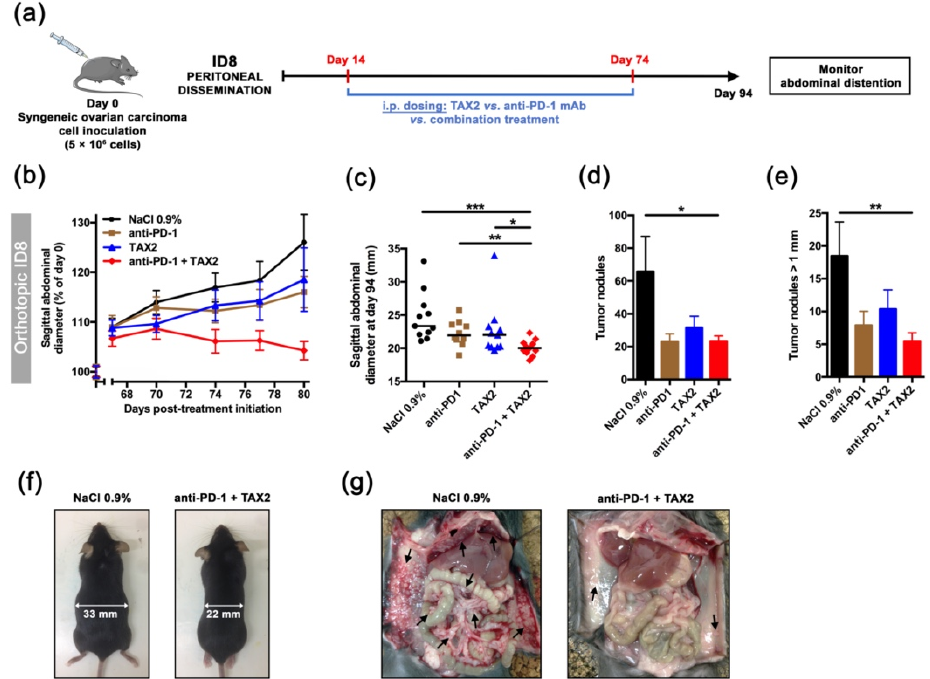
Figure 6. Validation in an orthotopic, syngeneic model of metastatic peritoneal carcinomatosis. ( a – g ) 5 × 10 6 ID8 cells were i.p. implanted in C57BL/6JRj mice in order to recapitulate peritoneal metastatic dissemination ( a ). On day 14, mice were randomized ( n = 11 per group) and then received the following treatments i.p.: 0.9% NaCl (100 µ L, thrice weekly, black circles), TAX2 peptide (30 mg · kg − 1 mouse weight, thrice weekly, blue triangles), anti-mouse PD-1 mAb (200 µ g, twice weekly, brown squares) and combined TAX2/anti-PD-1 therapy (red diamonds). Treatments lasted 8 weeks, during which abdominal distension (as it reflects ascites fluid production) was monitored. ( b ) Evolution of sagittal abdominal diameters, expressed as a percent of measured diameter at treatment initiation (mean ± SEM). ( c ) Scatter dot plot displays individual sagittal abdominal diameters on day 94 (i.e., 80-day post-treatment initiation), with median indicated as black line (Mann–Whitney U test, * p < 0.05, ** p < 0.01, *** p < 0.001). ( f ) Representative photographs of mice at study termination. ( d - e ) Histograms show the total number of peritoneal tumor nodules ( d ), as well as tumor nodules with diameter being over 1 mm ( e ), as counted during mice necropsy and expressed as mean ± SEM (Mann–Whitney U test, * p < 0.05, ** p < 0.01). ( g ) Gross necropsy evaluation for control and combination therapy groups (arrows indicate intraperitoneal tumor